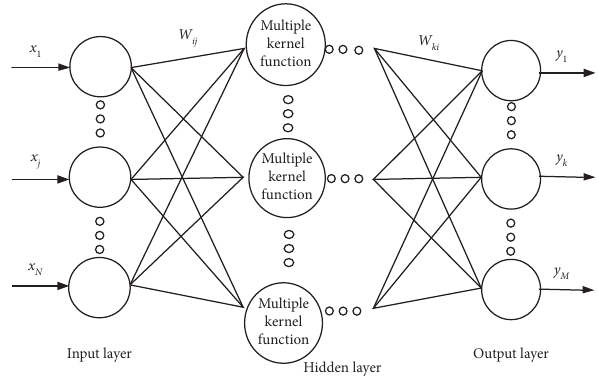
Figure 1: Neural network model structure based on multiple kernel